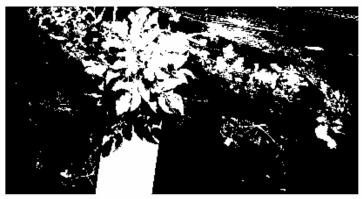
Figure 6. Segmentation result using OTSU algorithm of the image at 887 nm.